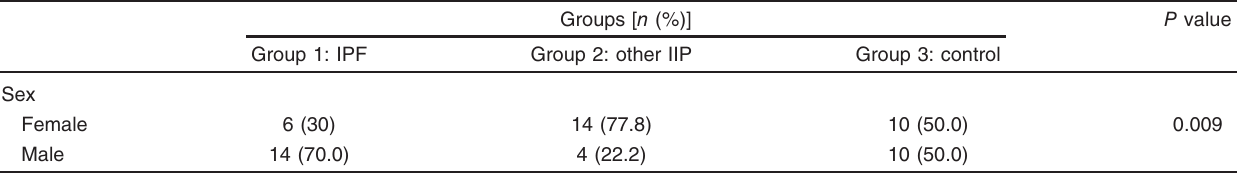
Table 1 Sex distribution among the study population